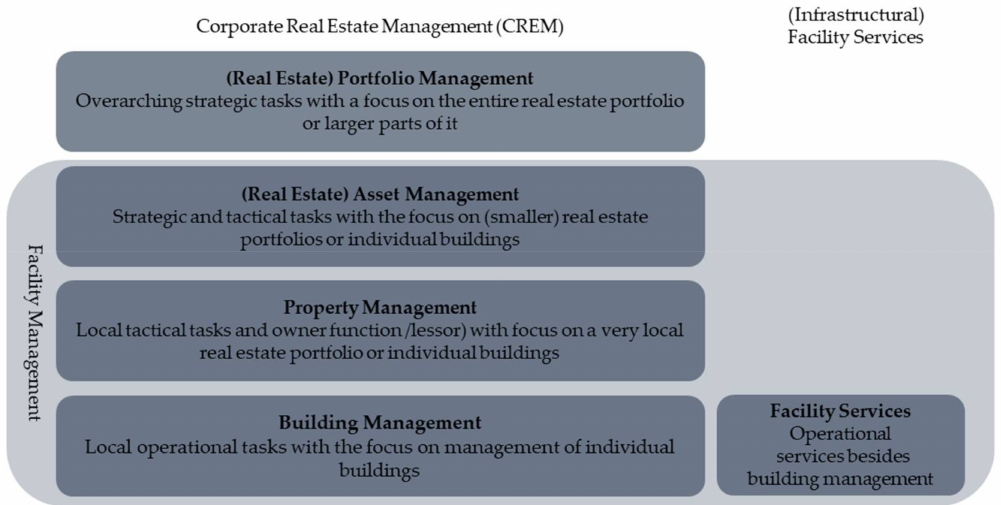
Figure 2. Disciplines of corporate real estate management and infrasturctural facility